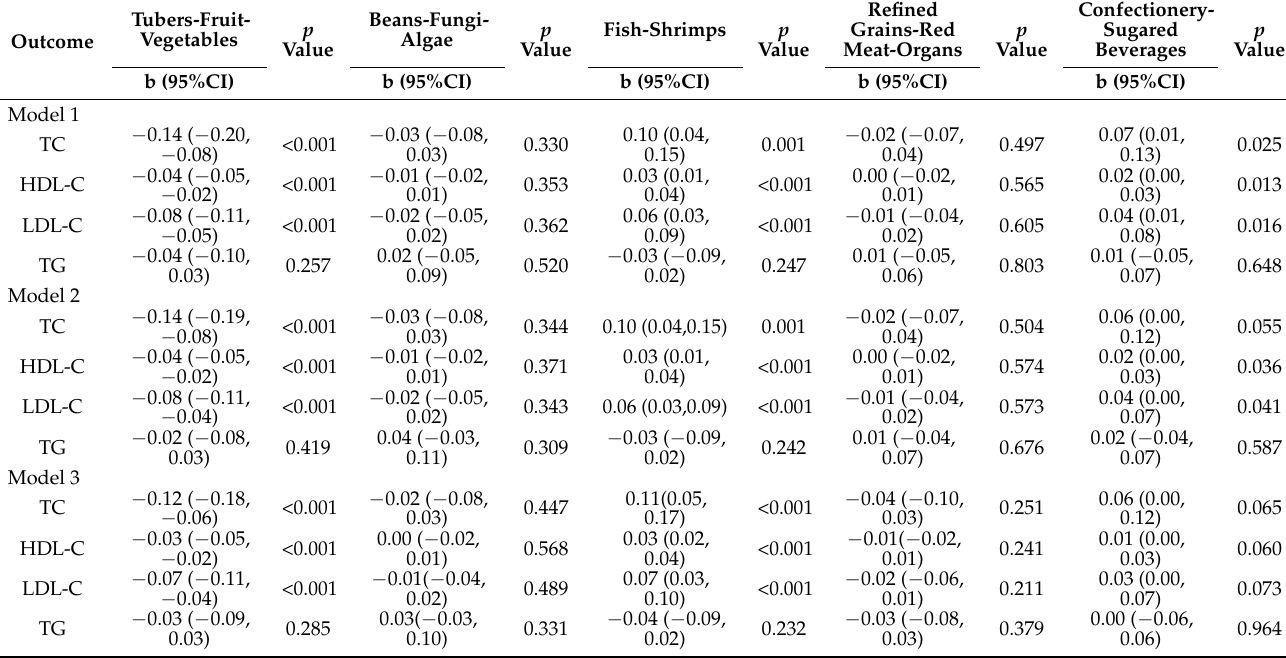
second, and third trimesters, respectively). TC total cholesterol, HDL-C high-density lipoprotein cholesterol, LDL-C low-density lipoprotein cholesterol, TG triacylglycerol. Data are shown as box and whiskers (2.5–97.5%), non-parametric tests, and the Bonferroni multiple comparison procedure used for the post hoc testing, with all p values < 0.001. Table 5. Longitudinal associations between dietary patterns and serum lipid concentrations during pregnancy *. Tubers-Fruit- Outcome